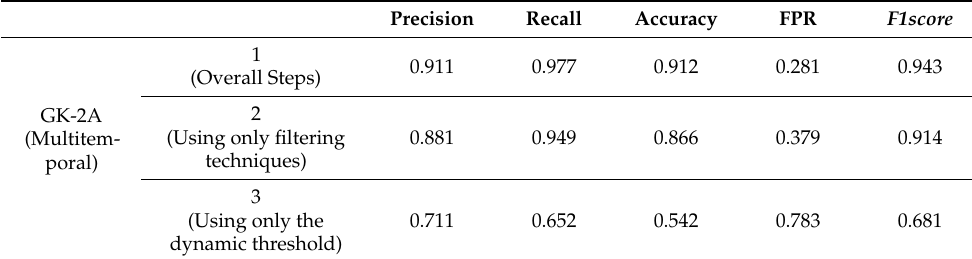
Table 4. Accuracy test for each step of the GK-2A multitemporal cloud detection algorithm. Precision Recall Accuracy FPR